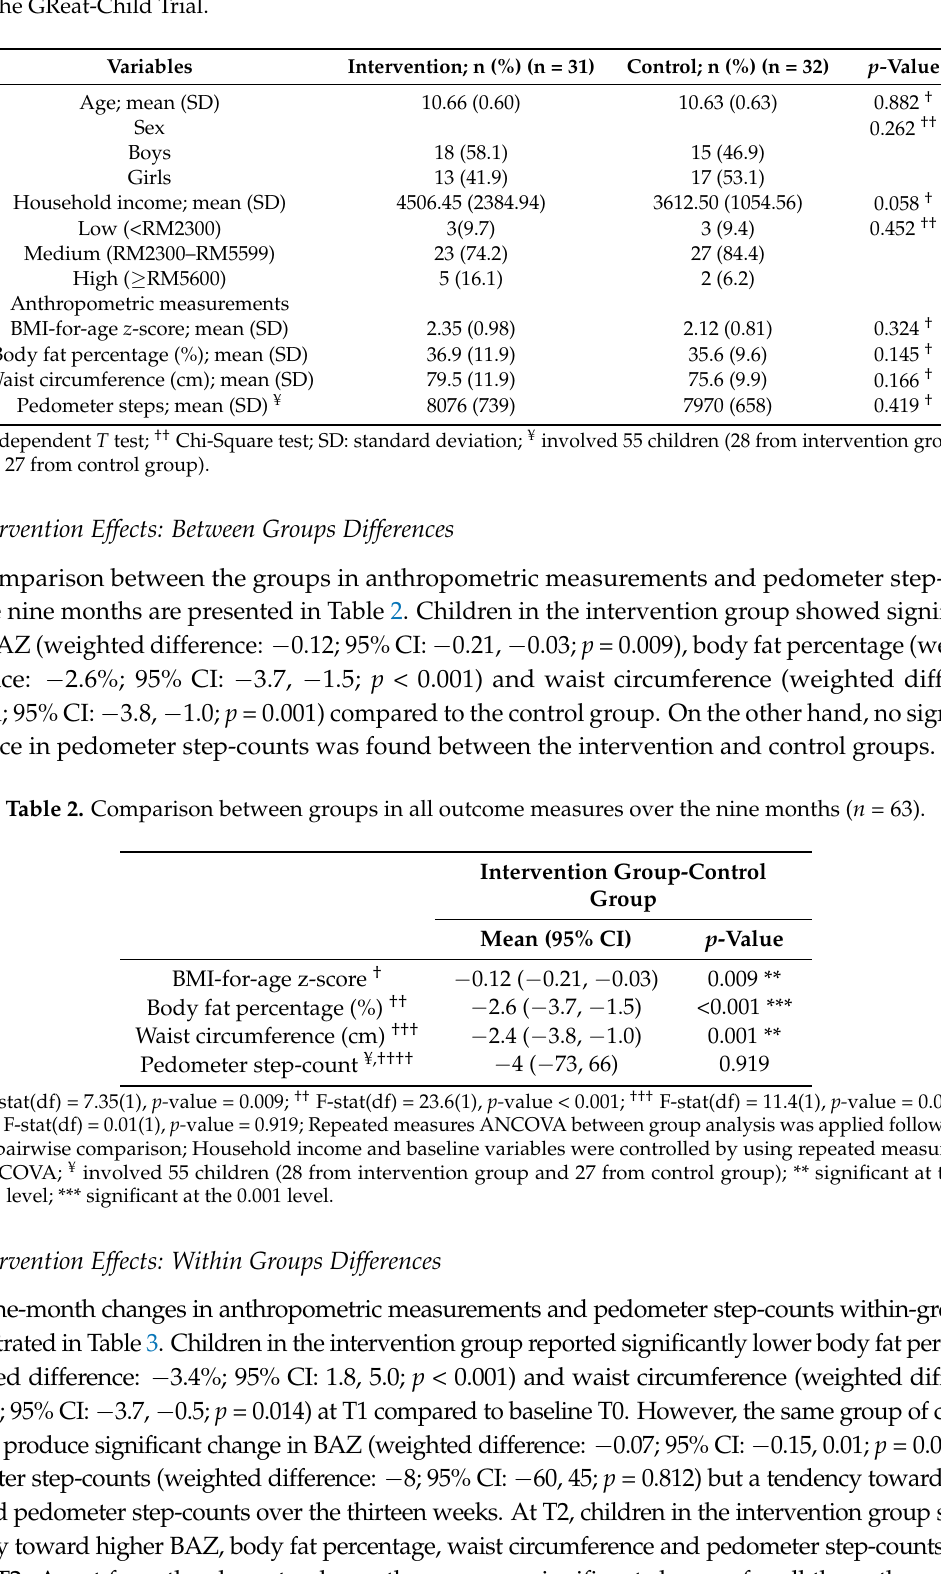
Table 1. Baseline demographic characteristic, anthropometric measurements and pedometer step-count in the GReat-Child Trial.